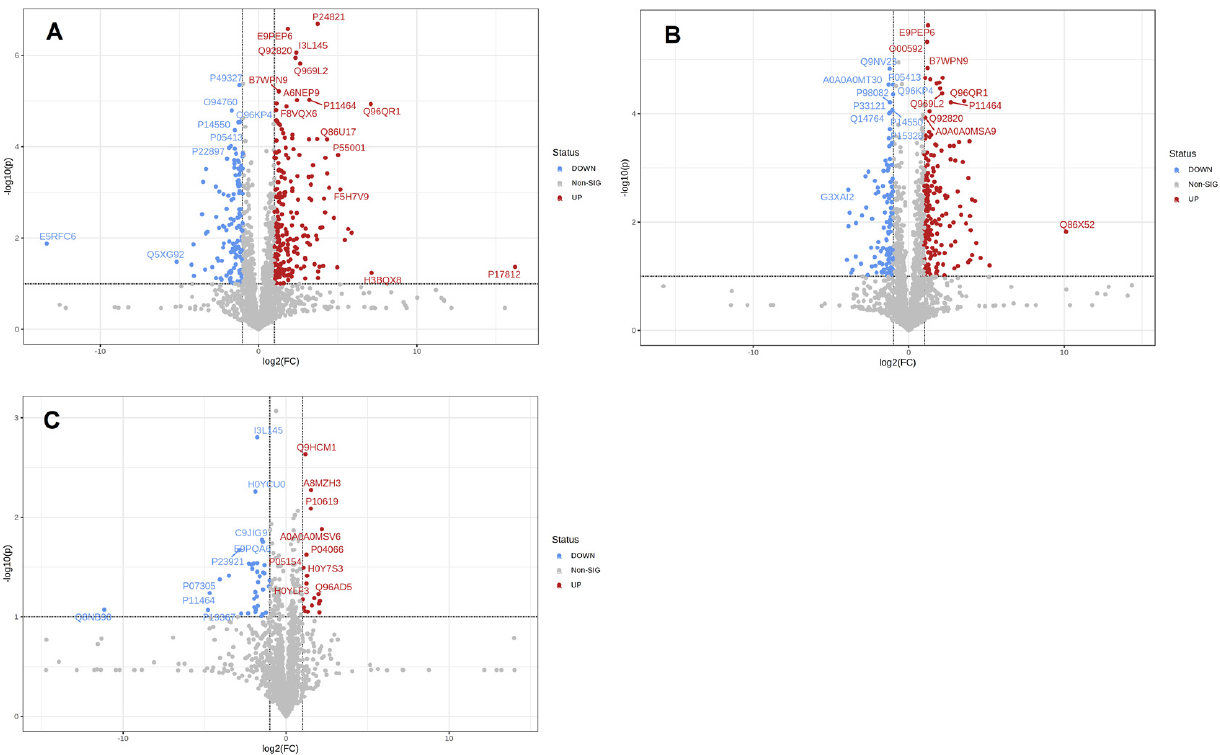
Figure 3. Differential expression of proteins between groups. Volcano plot showing the significance versus fold change in C vs. M ( A ), C vs. T ( B ), and M vs. T ( C ). Down-regulated proteins are shown in red, and up-regulated proteins are shown in blue.